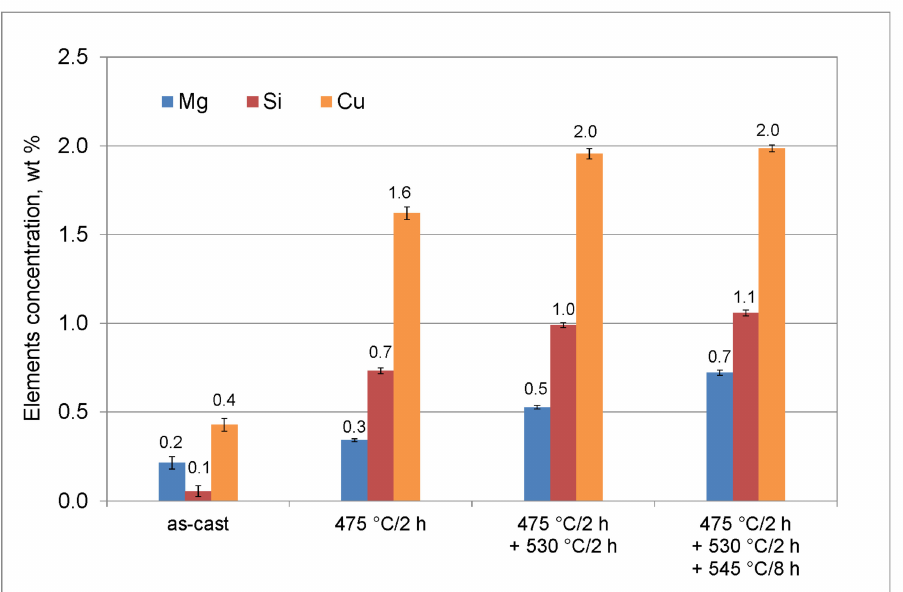
Figure 6. Concentration of Mg, Si, and Cu in dendrites/grains interiors in as-cast state and after each soaking stage (followed by water quenching). Error bars indicate standard deviation of the mean.